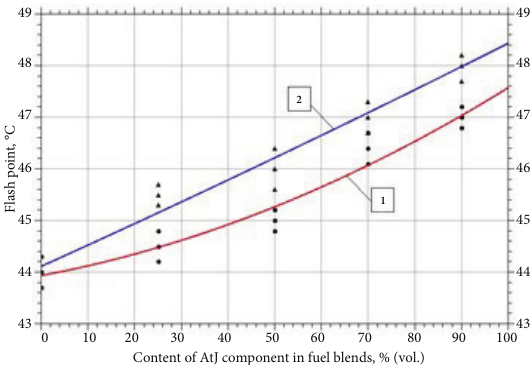
Figure 6. Dependence of the flash point of JF blends on the content of AtJ components produced from alcohols: 1 – AtJ-SPK component, 2 – AtJ-SKA